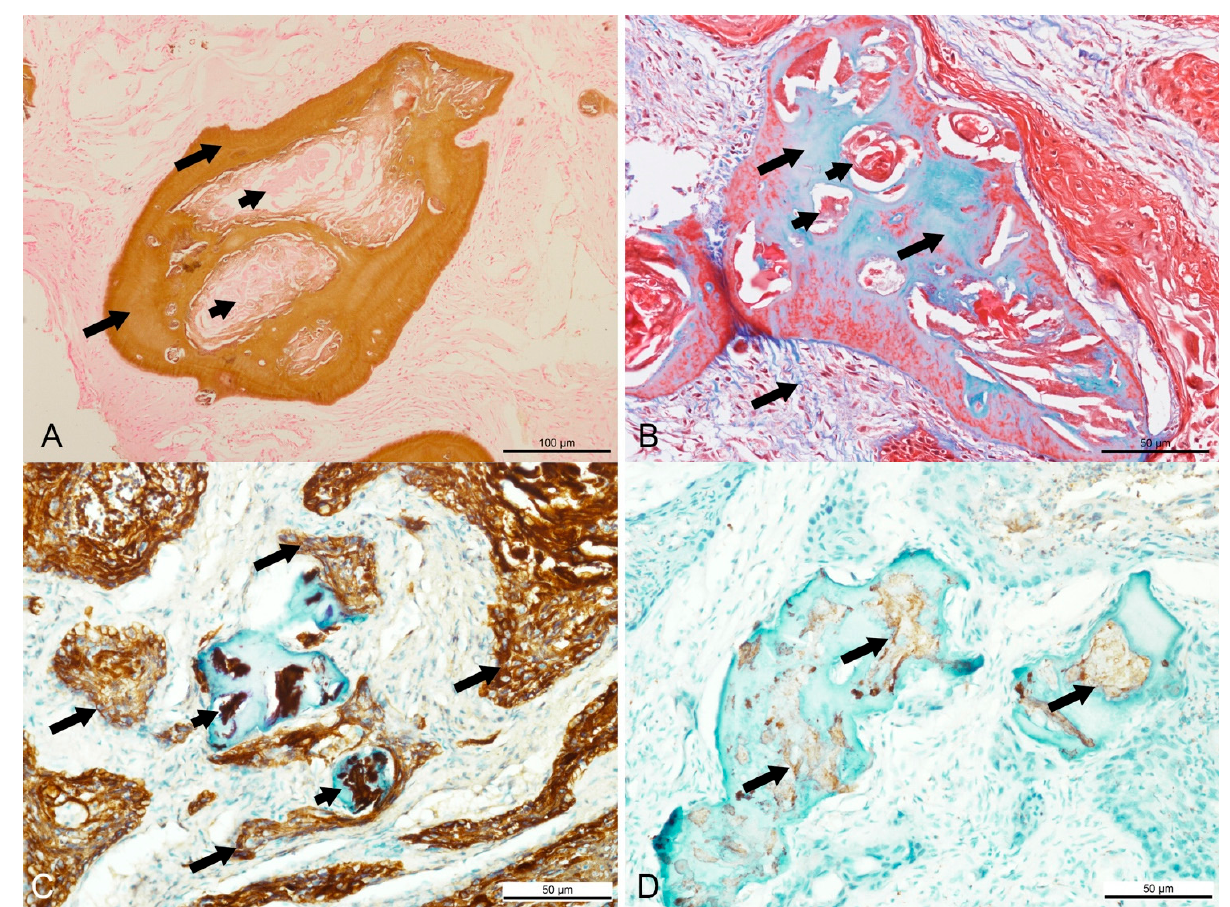
Figure 2. Special histochemical and immunohistochemistry findings in a Sumatran rhinoceros with a dentinogenic ghost cell tumor. ( A ) Brown stain of Von Kossa indicating the presence of calcium in the dentinoid material (long arrow), while most keratin pearls were devoid of calcium (short arrows). Von Kossa, bar = 100 µm. ( B ) Bone tissue stained in blue and keratin stained in red with Masson’s trichrome. Masson’s trichrome, bar = 50 µm. ( C ) Intense intracytoplasmic staining for cytokeratin AE1/AE3 in the neoplastic squamous cells (long arrows) and keratin pearls (short arrows). AE1/AE3, bar = 50 µm. ( D ) Mild positive staining for S-100 in the ghost cells and keratin (arrows) located inside the dentinoid material. S- 100, bar = 50 µm.